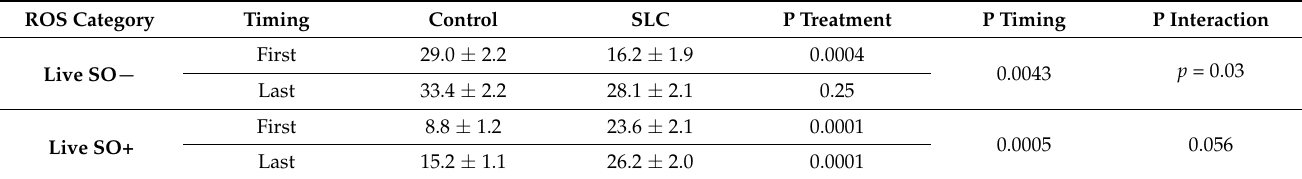
Table 3. Reactive oxygen species in SLC and control samples (LSMeans ± SE) in first and last young bull ejaculates (n = 19